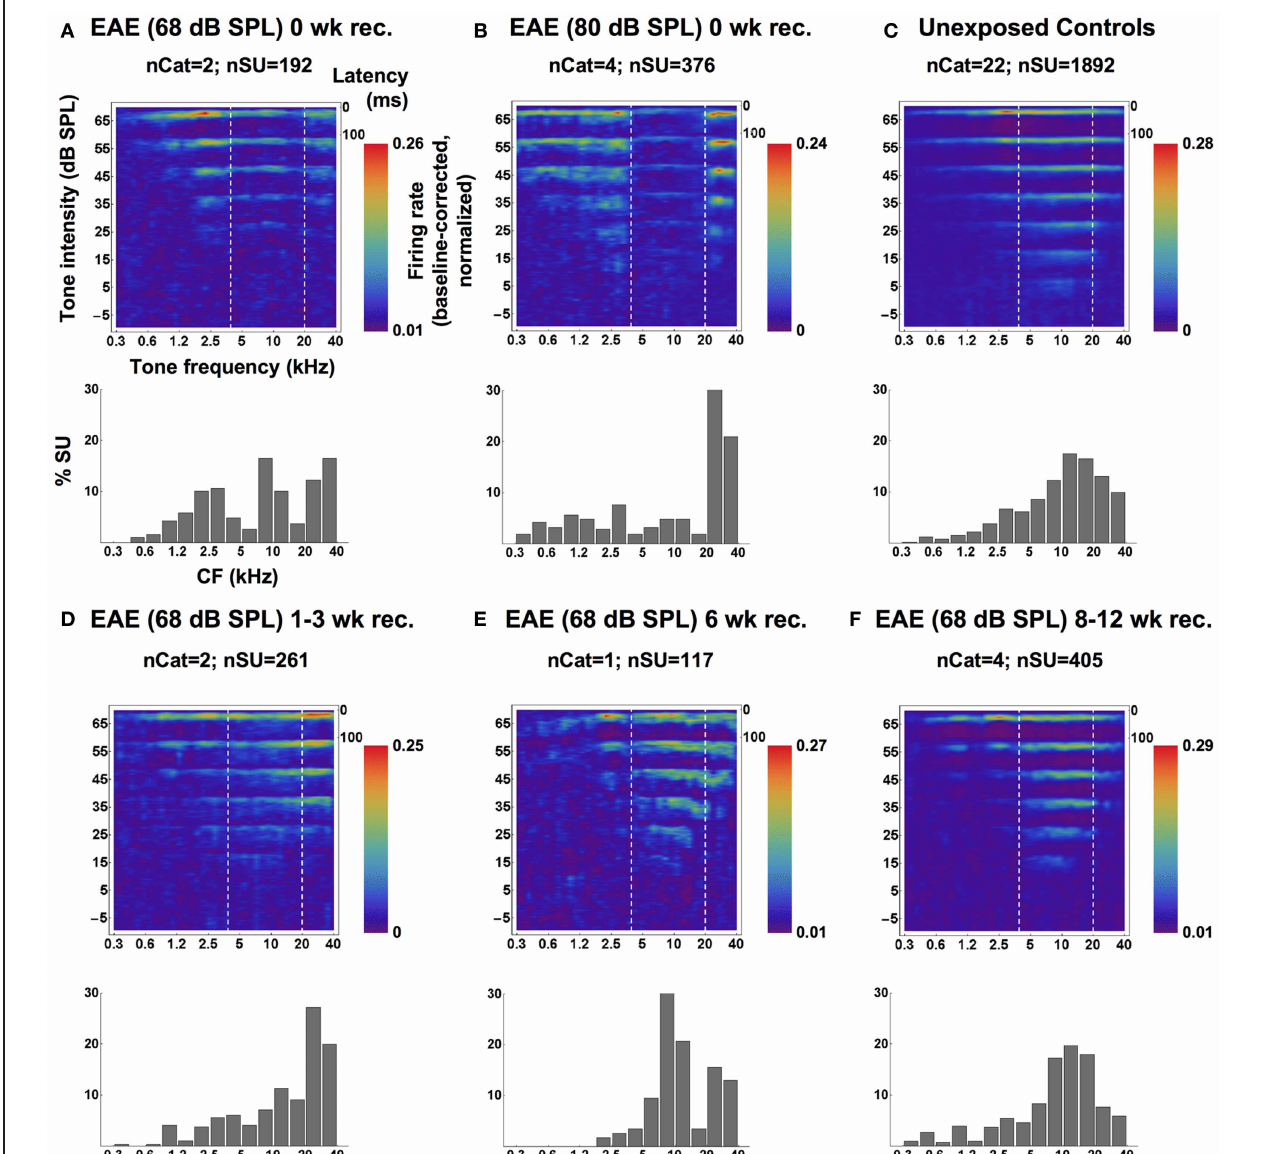
FIGURE 3 | Averaged SU-derived frequency tuning curves (top panels) and CF distributions (bottom panels; bin-width = 1/2 octave), measured from groups of cats immediately following the 6-weeks EAE exposure at 68dB SPL (A) and a 20-weeks exposure 80dB SPL (B), from a group of unexposed controls (C), and from groups of cats exposed at 68dB SPL and allowed 1–3 weeks (D), 6 weeks (E) or 8–12 weeks (F) of recovery. In the top panels, averaged SU responses to individually-presented tone pips (at